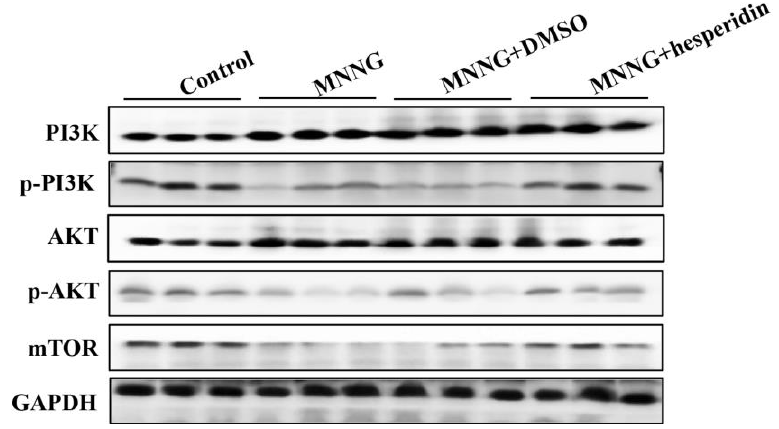
Figure 7. Hesperidin reversed the MNNG-inhibited PI3K/AKT pathway. Rats were divided into a control group, an MNNG group, an MNNG and solvent control group, and an MNNG and hesperidin group. Hesperidin reversed the MNNG-inhibited PI3K/AKT pathway in the gastric tissues of rats. Western blotting analyzed expression changes of phosphorylated PI3K and phosphorylated AKT. Tissues were from n = 3 rats as representative images.